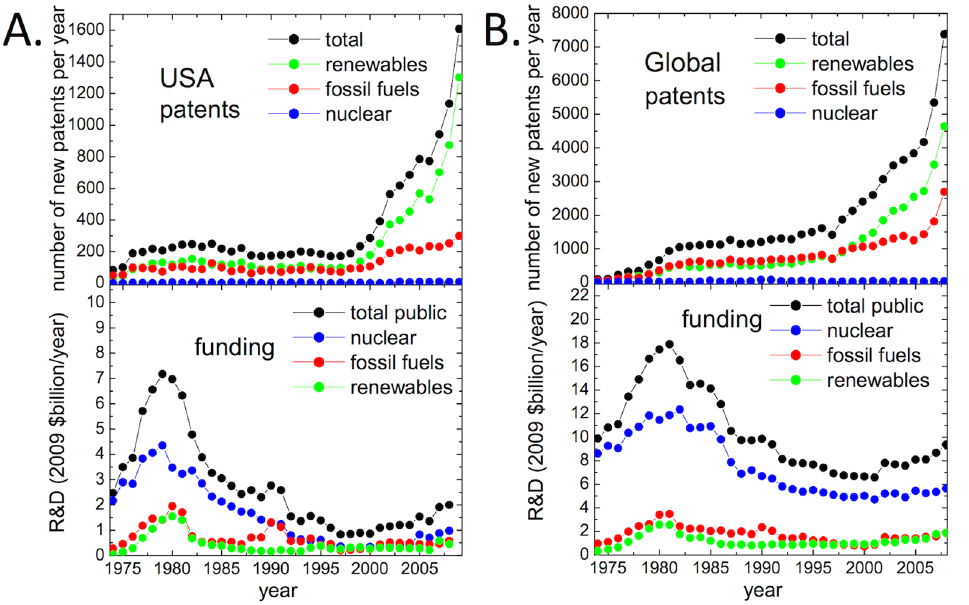
Figure 1. Temporal trends in energy patents. (A.) Time series for US energy patents published during the period 1974-2009 show rapid growth over the last decade (upper panel), with the greatest increases in renewables patents. Public funding (lower panel) for energy R&D (1974-2008) increased dramatically in the 70s and 80s but then remained relatively constant. (B.) A similar trend in patenting (1974-2008) is seen when aggregating globally (upper panel). Funding for public R&D (1974-2008) among IEA countries (lower panel) shows only modest increases in recent years.